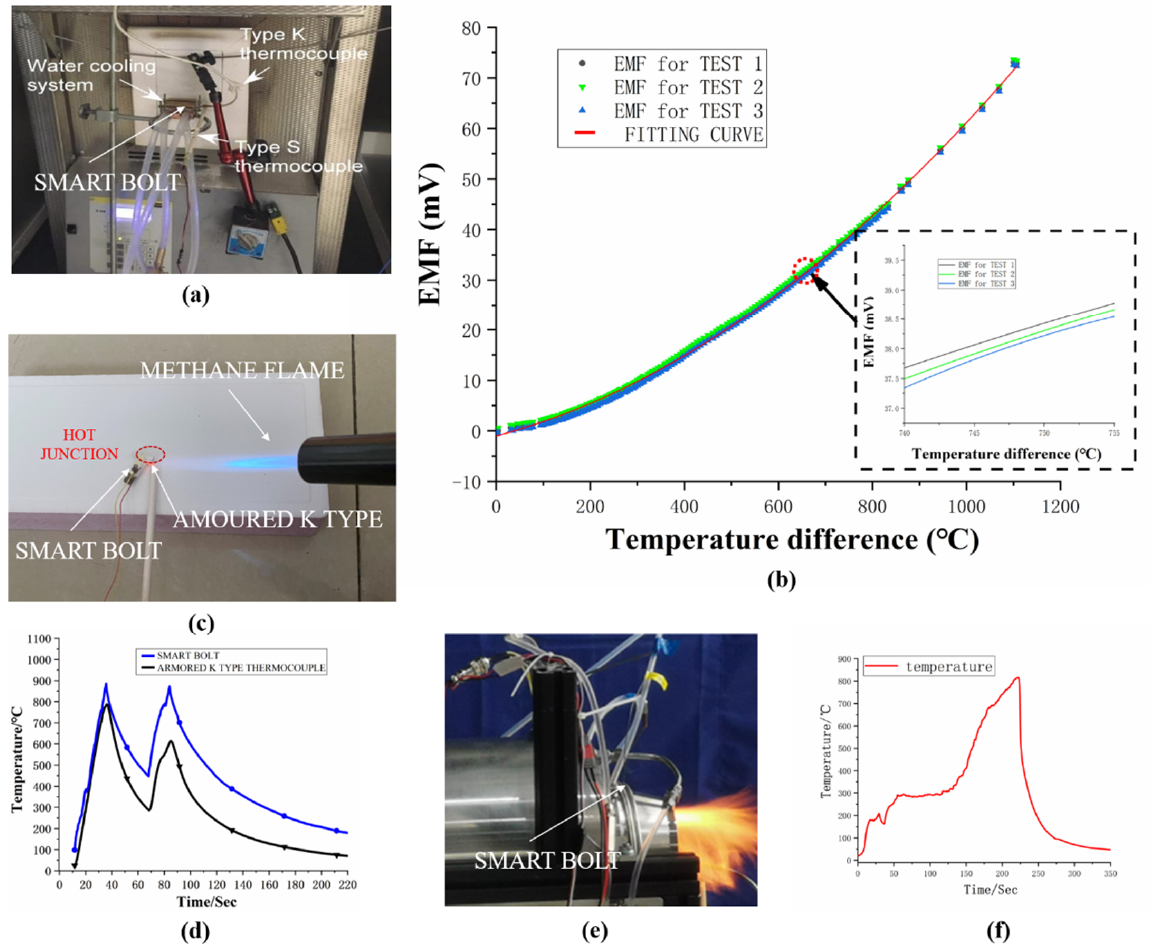
Figure 10. The temperature calibration system ( a ), EMF output of the sensor in three cycles of heating and cooling with the maximum temperature difference of 1100 °C ( b ), methane flame test system ( c ), EMF output of the smart bolt and armored K-type thermocouple under methane flame test up to 1000 °C ( d ), smart bolt which is installed on a small aero engine for ignition test ( e ), diagram of temperature test results during ignition ( f ).